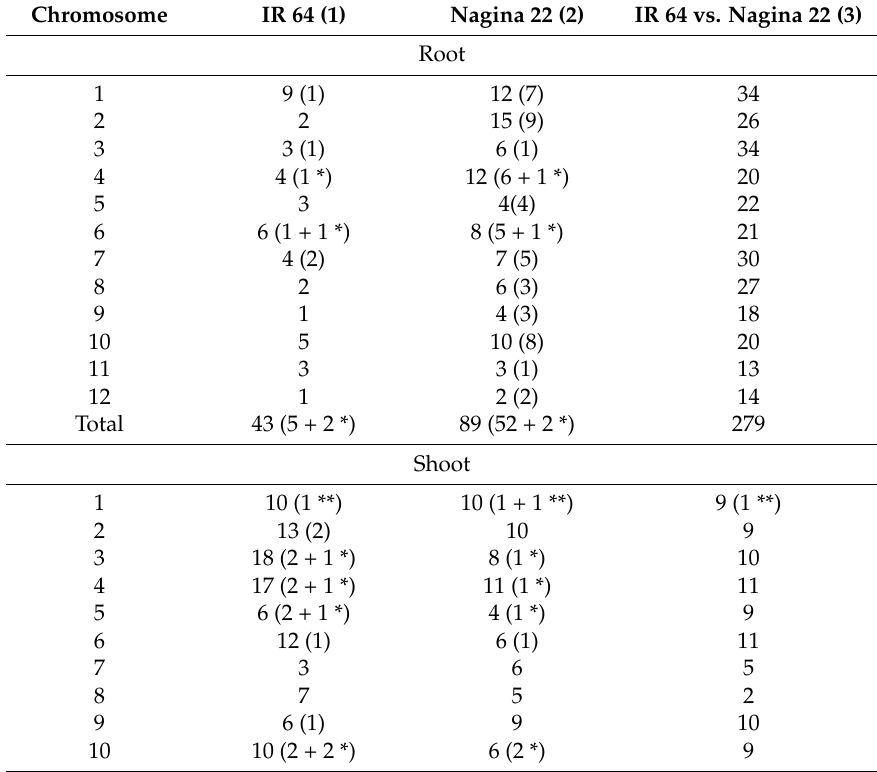
Table 3. Chromosome-wise summary of DEGs identified between optimal and low N in IR 64, Nagina 22 and the N-responsive DEGs between the two